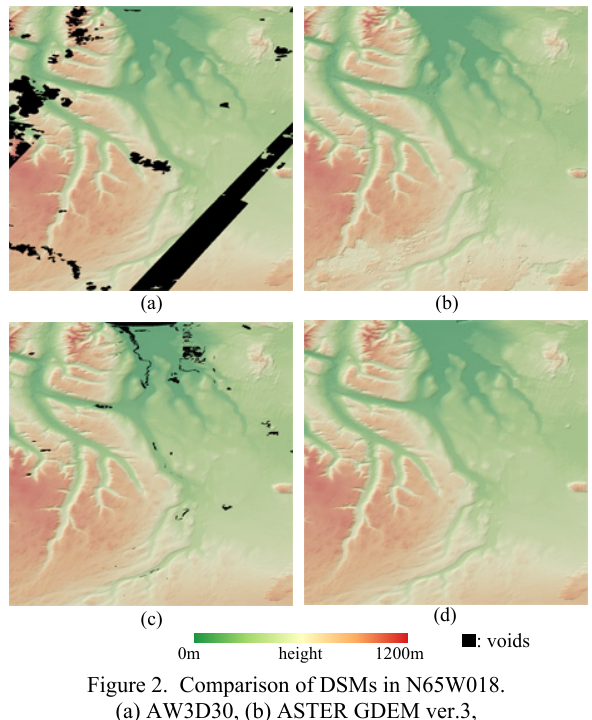
Figure 2. Comparison of DSMs in N65W018. (a) AW3D30, (b) ASTER GDEM ver.3, (c) ArcticDEM ver.3, (d) TDX 90m DEM.